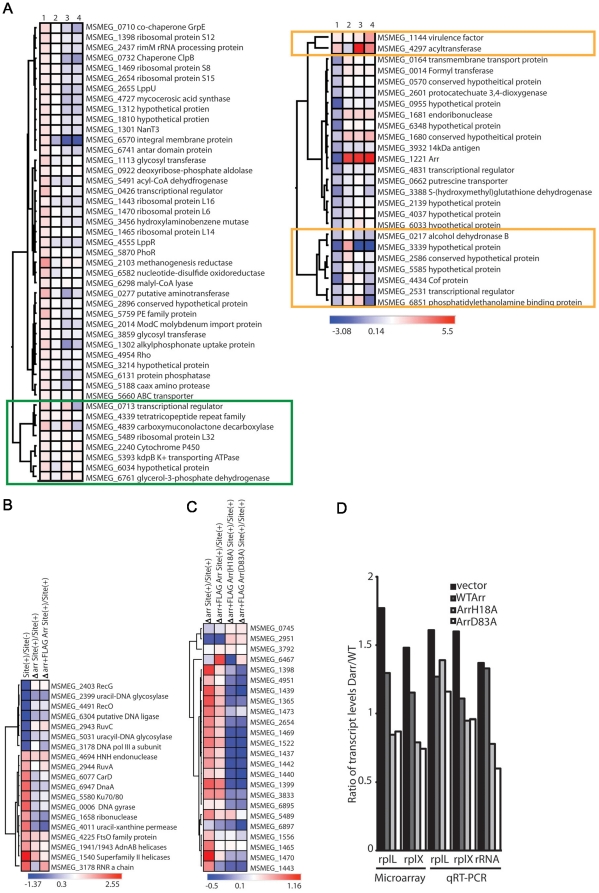
Catalytic and noncatalytic roles for Arr in the DNA damage response.Microarray and qRT-PCR experiments compared Δarr site(+) strains expressing wild-type FLAG-Arr, FLAG-Arr(H18A), FLAG-Arr(D83A), or containing an empty expression vector (vector) to the original site(+) strain (mgm182) during exponential growth phase. All experiments were done in the absence of ATc when low levels of DSBs are occurring. A. The heat map shows the log2 ratio of transcripts that were up or downregulated 1.5× in Δarr site(+) compared to wild type site(+) and complemented by expression of FLAG-Arr. Column 1 represents the ratio of Δarr+vector site(+)/site(+), column 2 is Δarr+FLAG-Arr site(+)/site (+), column 3 is Δarr+FLAG-Arr(H18A) site(+)/site(+), and column 4 is Δarr+FLAG-Arr(D83A)/site(+). The orange boxes highlight genes for which the up (2 genes) or downregulation (7 genes) observed in Δarr cells (column 1) was not complemented by Arr(H18A) or Arr(D83A). The green box highlights genes in which the wild type expression pattern was restored by either Arr(H18A) or Arr(D83A). The heat maps only show genes that gave p values≤0.05. B. The heat map shows the log2 ratio of transcripts encoding DNA repair proteins that were up or downregulated 2× in site(+) compared to site(−). Column 1 is site(+)/site(−), column 2 is Δarr site(+)/site(+), and column 3 is Δarr+FLAG-Arr site(+)/site(+). The heat maps only show genes that gave p values≤0.05. C. The heat map shows the log2 ratio of ribosomal protein transcripts in Δarr site(+) strains compared to wild-type site(+). Column 1 is Δarr+vector site(+), column 2 is Δarr+FLAG-Arr site(+), column 3 is Δarr+FLAG-Arr(H18A) site(+), and column 4 is Δarr+FLAG-Arr(D83A), each compared to wild-type site(+). The heat maps only show genes that gave p values≤0.05. D. Mean ratios of rplL, rplX, and 16S rRNA transcript levels in M. smegmatis Δarr site(+) expressing wild-type FLAG-Arr, FLAG-tagged Arr point mutants, or containing an empty expression vector (vector) as compared to levels in original site(+) strain (mgm182) as determined by microarray or qRT-PCR. All experiments were done with exponential phase cultures in triplicate without ATc and therefore reflect basal expression of the I-SceI endonuclease equivalent to T = 0 in the microarray experiments.